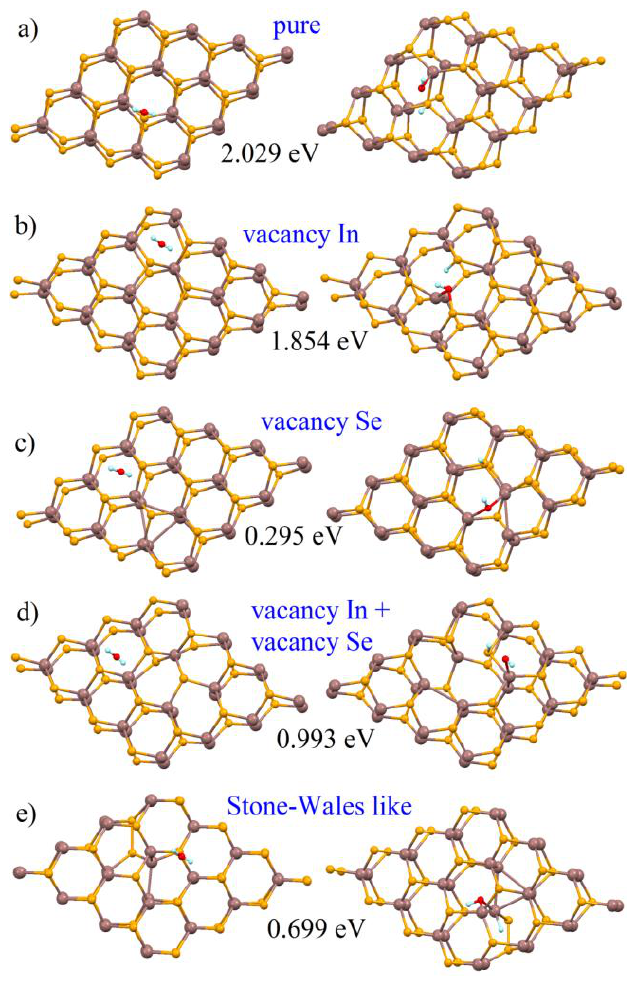
Figure 11. Atomic structure of pristine ( a ) and defective ( b – e ) InSe monolayer before ( left ) and after ( right ) the decomposition of the water molecules. The indicated values represent the energy cost of the dissociation of water molecules for each specific case. Reproduced with permission from Ref. [20]. Copyright Royal Society of Chemistry, 2016.